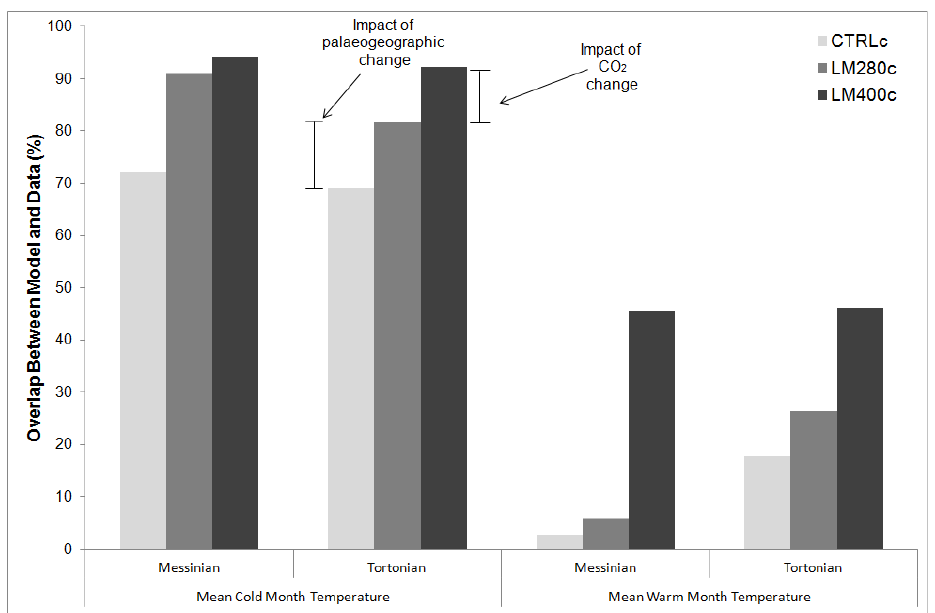
Fig. 18. Model–data comparison summary for CMT and WMT. Shown are the percentages of the total number of datapoints that overlap with the model